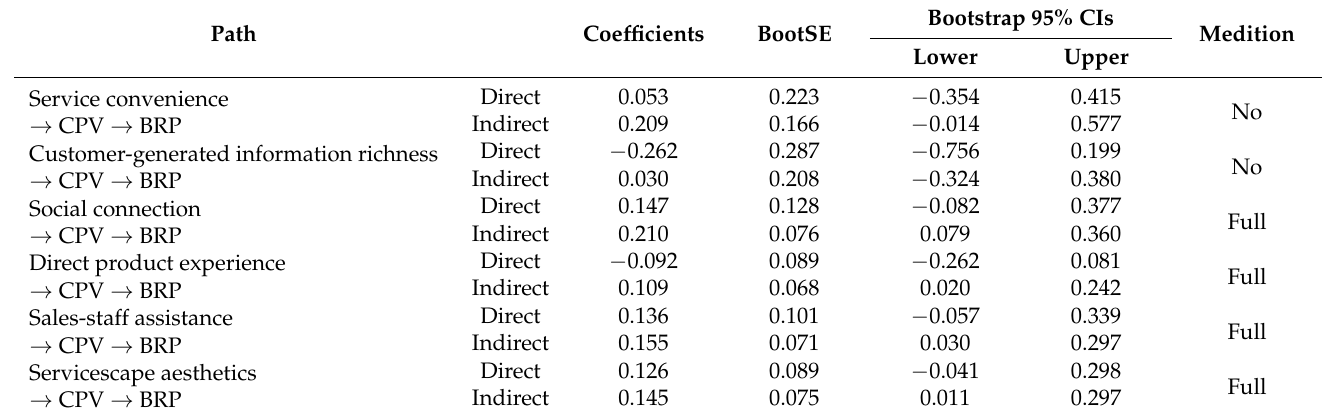
Table 7. Mediation